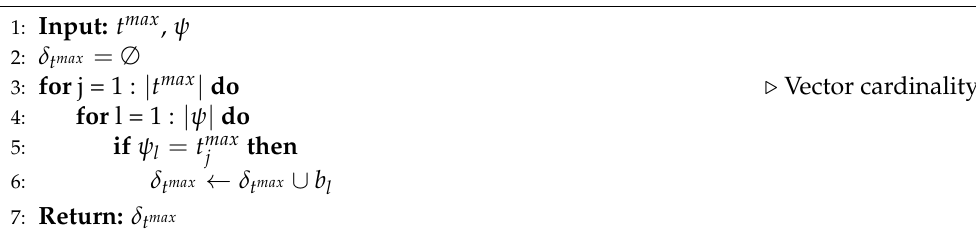
Algorithm 2 The most correlated bands to a given